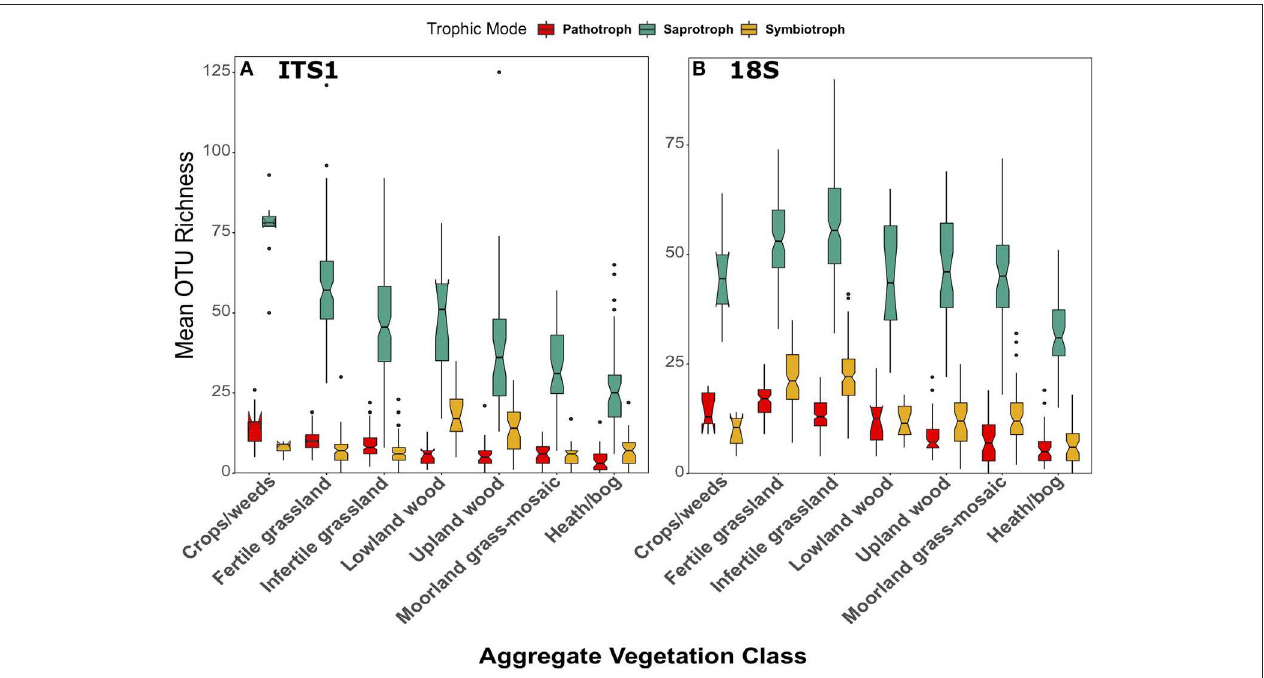
FIGURE 8 | Boxplots of richness of fungal OTUs matched to the pathotrophic, saprotroph, and symbiotroph trophic modes in FUNGuild for (A) ITS1 and (B) 18S datasets plotted against Aggregate Vegetation Class. Aggregate Vegetation Classes are ordered from most (Crops/weeds) to least (Heath/bog) productive. Boxes cover the first and third quartiles and horizontal lines denote the median. Black dots represent outliers beyond the whiskers, which cover 1.5X the interquartile range. Notches indicate confidence interval around the median. Overlapping notches are a proxy for non-significant differences between medians. Black dots are outliers.